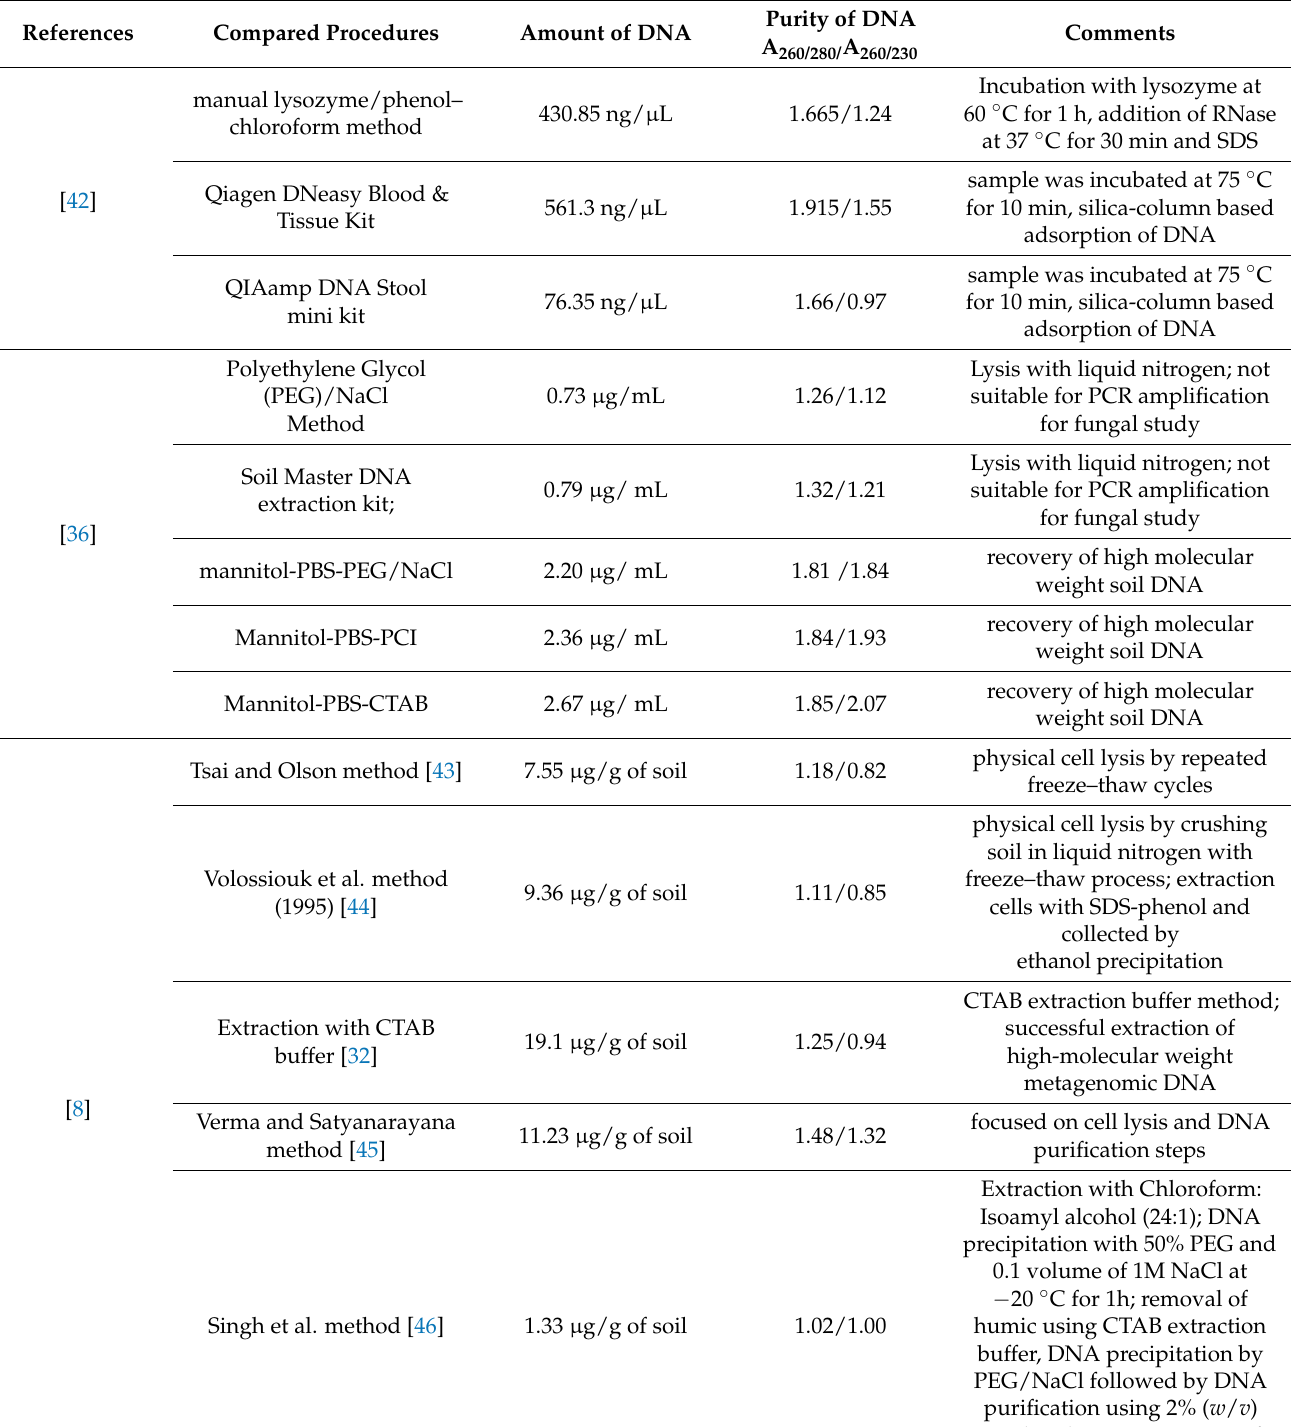
Table 1. Comparison of different soil DNA extraction